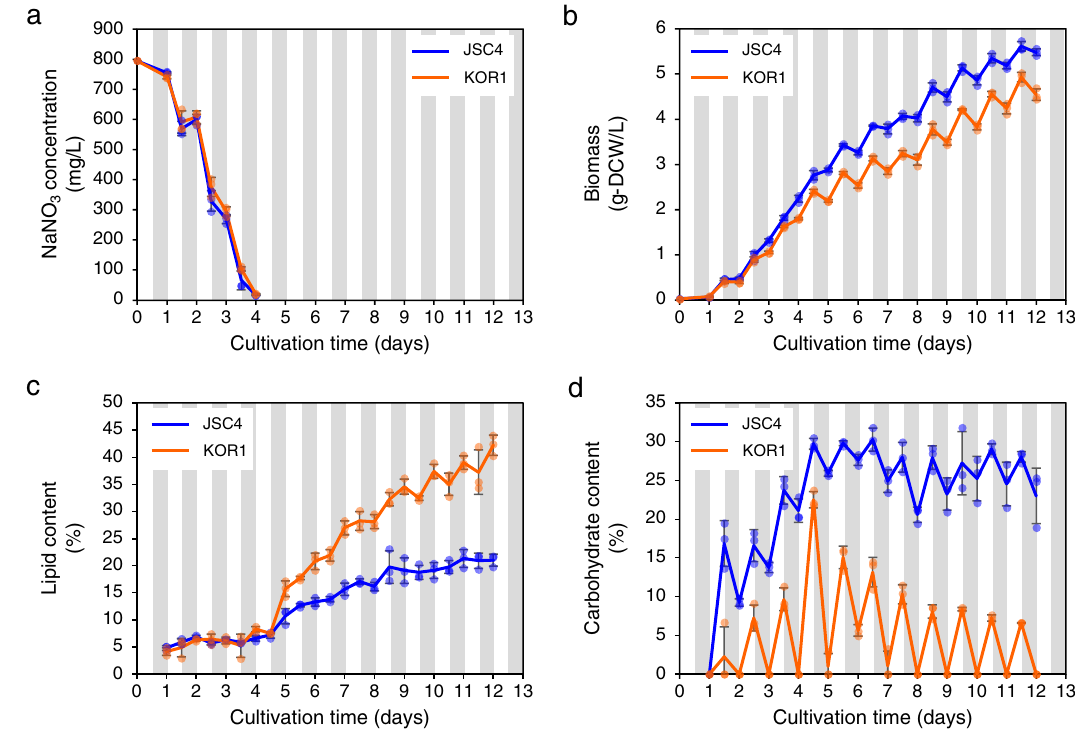
Fig. 1 Time-course pro fi les of nitrogen consumption and energy storage. a Residual nitrate concentration in the culture media. b Biomass. c Lipid content. d Carbohydrate content. White and gray bands represent light and dark periods, respectively. Error bars indicate the standard deviation of three replicate experiments.